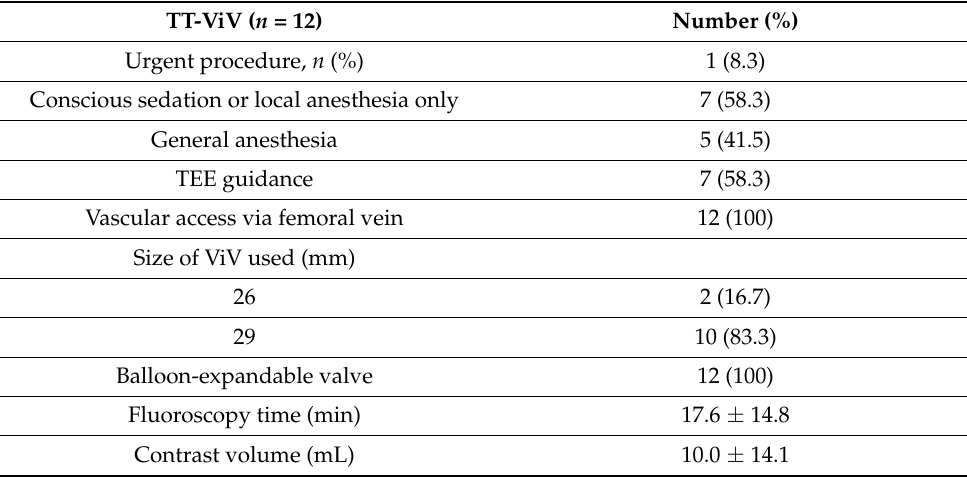
Table 2. Procedural characteristics: valve-in-valve tricuspid